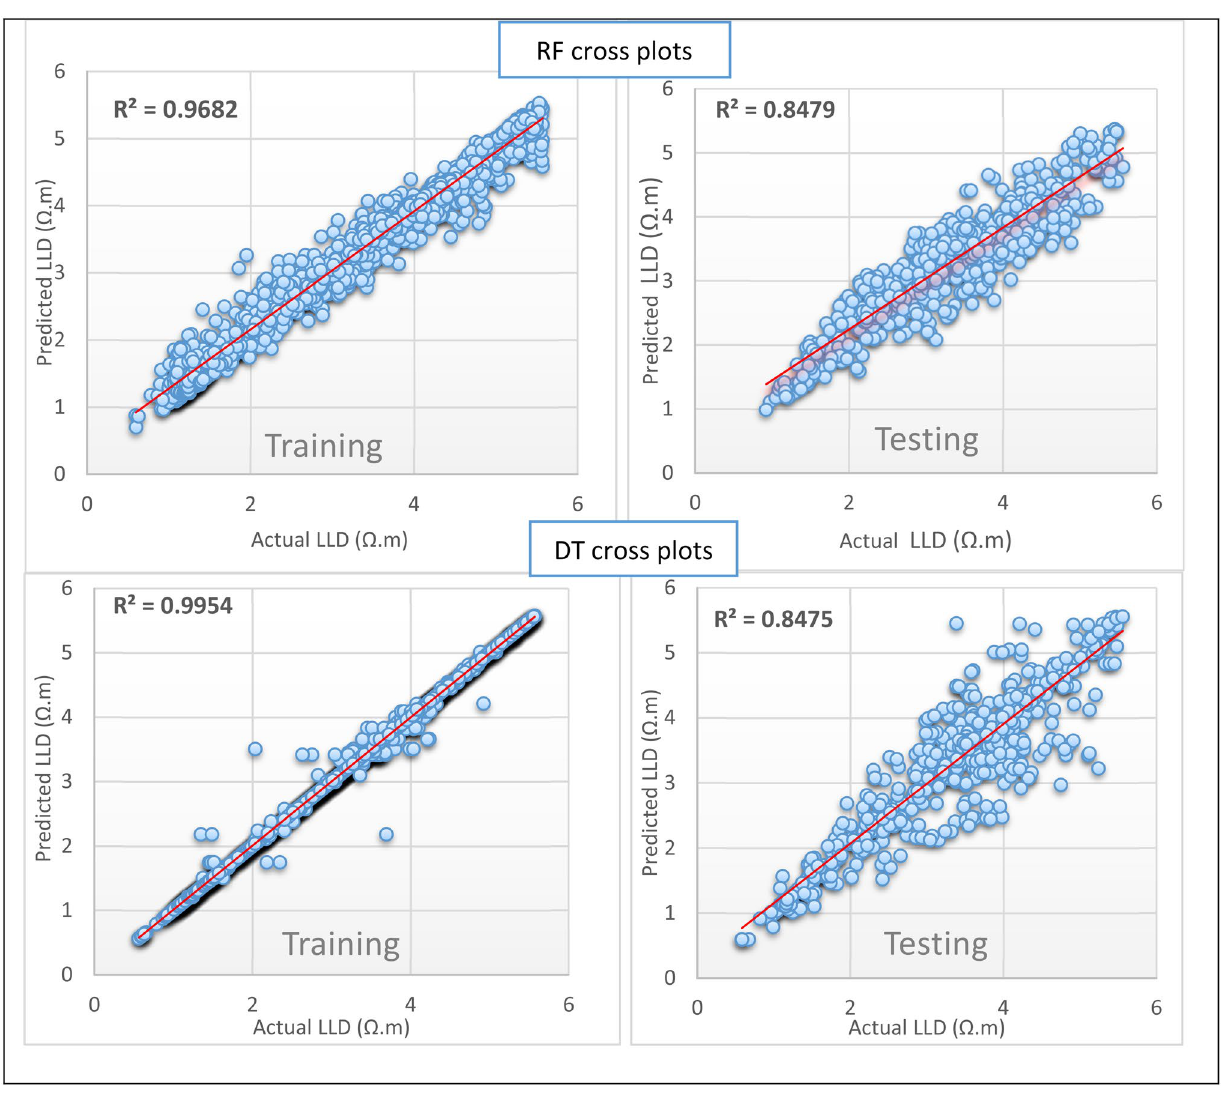
Fig. 2 Cross graphs of actual versus estimated oil well resistivity for the RF and DT models' training and testing